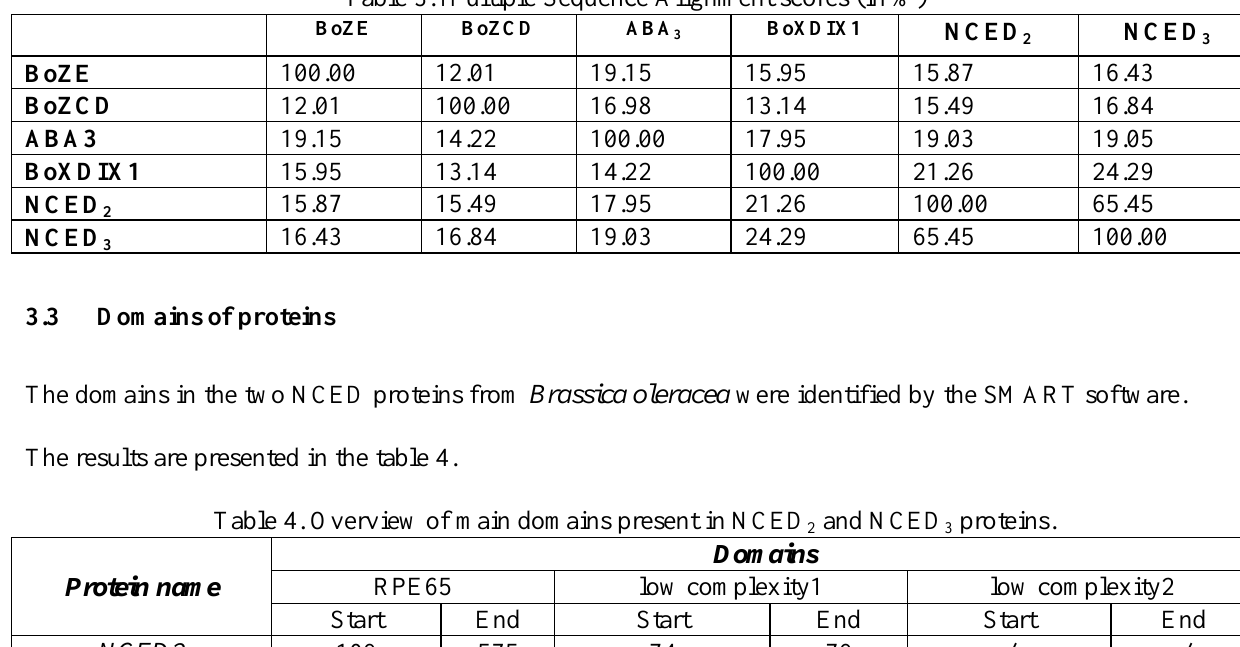
Table 4. Overview of main domains present in NCED